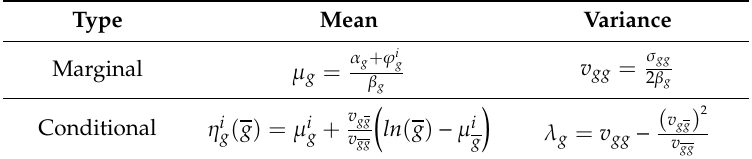
Table 10. Means and variances of stationary Gompertz-type marginal and conditional